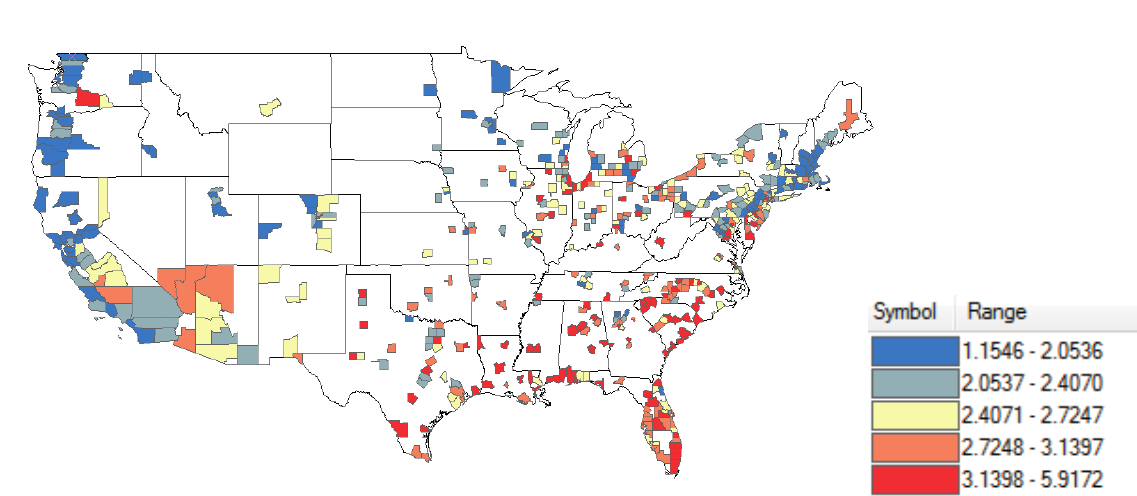
Figure 1. County prematurity percentage. N =